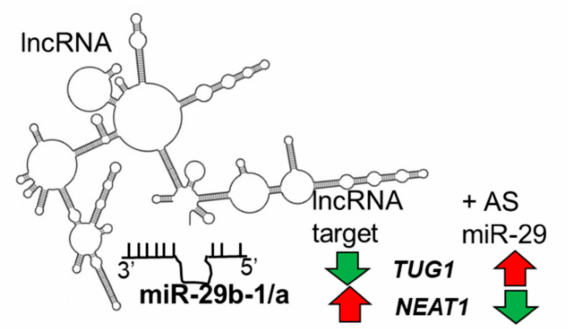
Figure 1. Model of identification of miR-29b-1/a regulation of lncRNAs in MCF-7 and LCC9 breast cancer cells. If an lncRNA (drawn in BioRender.com) is a target of miR-29b-1/a, then antisense (AS) miR-29 will block the effect of miR-29b-1/a on that lncRNA. The green arrow represents a decrease and the red arrow represents an increase in the lncRNA abundance in response to miR-29b-1-3p and or miR-29a-3p transfection that is blocked by AS-miR-29 (arrows in opposite directions). An example of a downregulated and an upregulated lncRNA detected in both MCF-7 and LCC9 cells from Tables 1 and 2 is